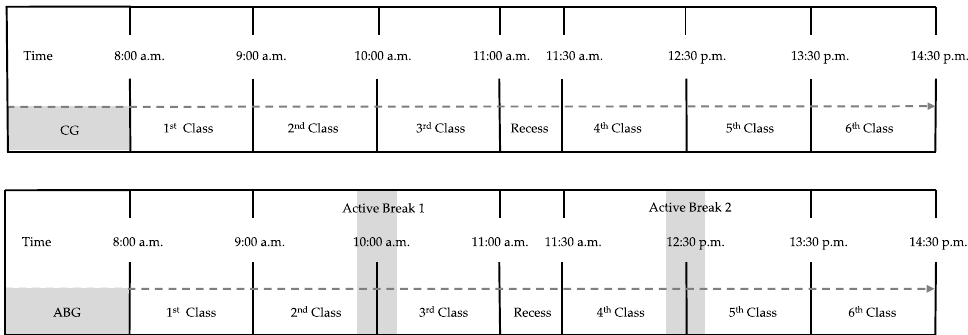
Figure 1. Schematic representation of the school day procedure of one session of the experimental group.